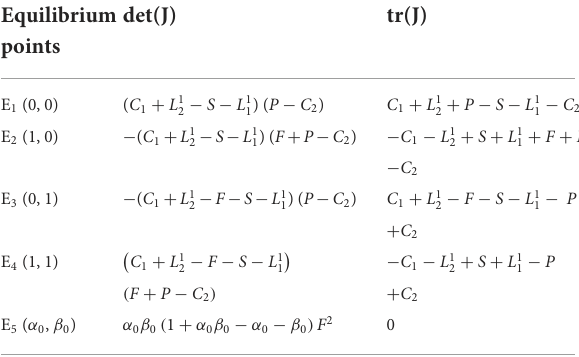
TABLE 3 The det(J) and tr(J) of equilibrium points.